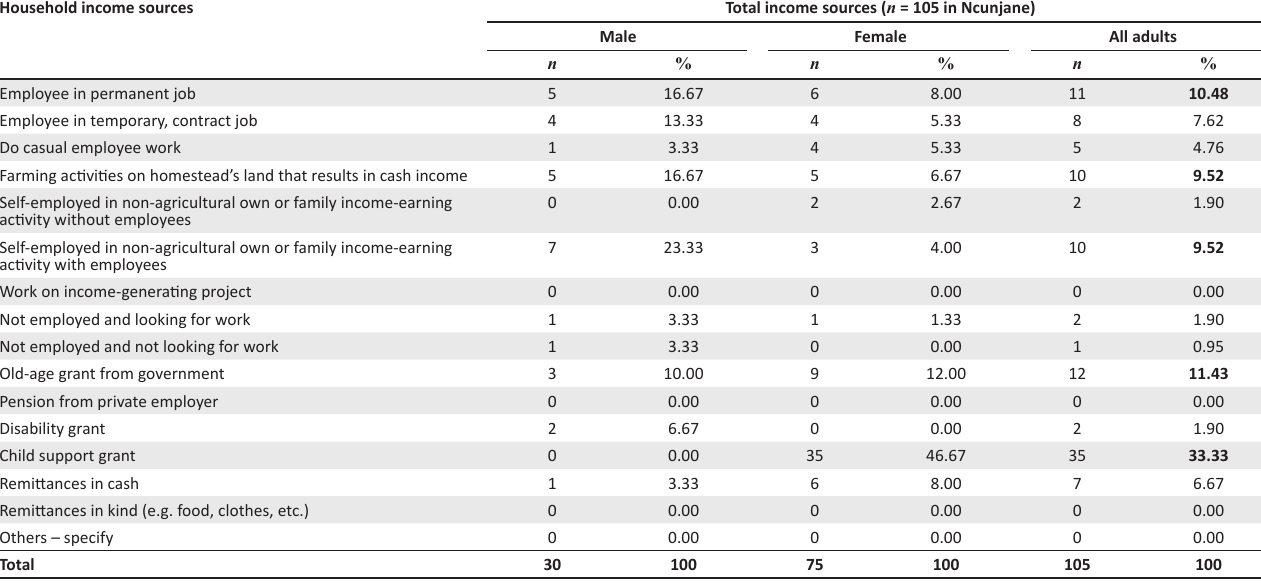
TABLE 3: Income sources of adult household members in Ncunjane. Household income sources